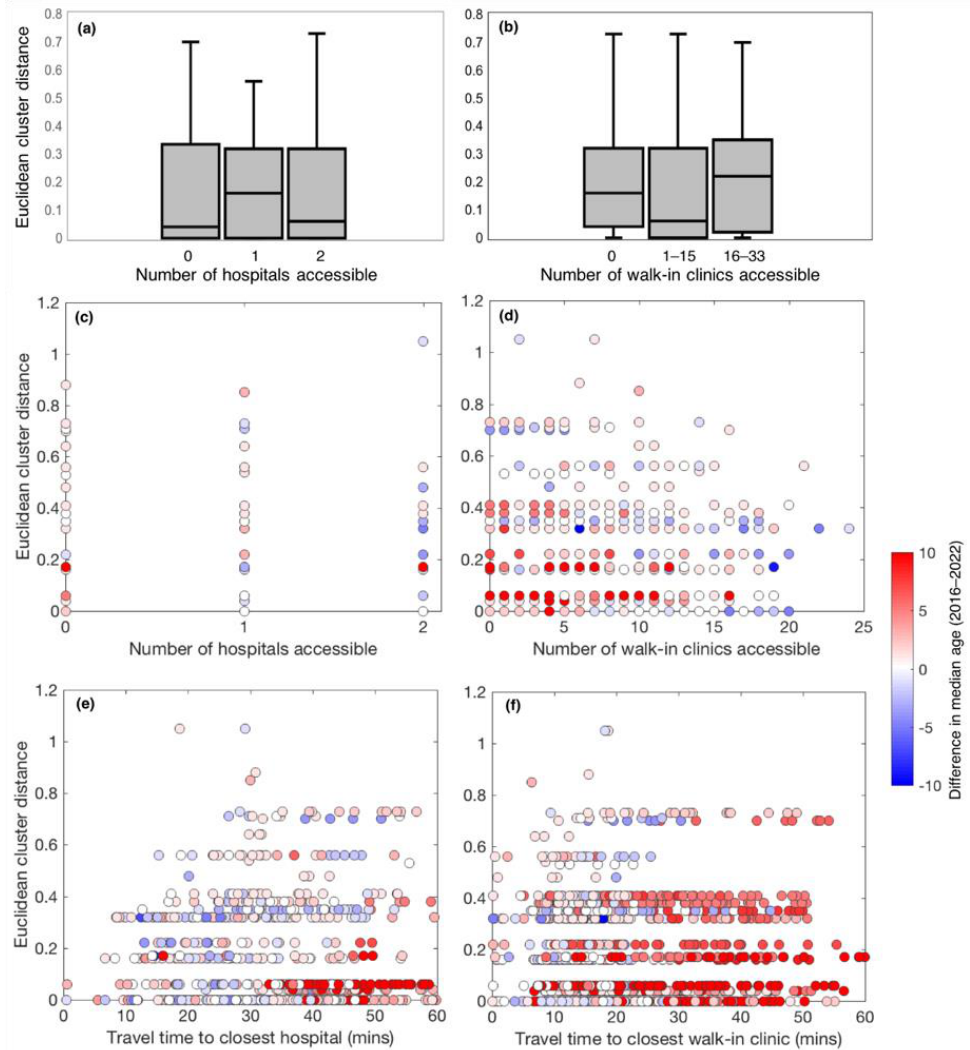
Figure 8. ( a , b ) Box-and-whisker plots of cluster distance, grouped by level of accessibility, to ( a ) hospitals and ( b ) walk-in clinics; ( c – f ) Scatterplots showing relationships between access to healthcare facilities and the Euclidean cluster distance for each cell, with a third (coloured) variable showing the difference in median age between 2016 and 2022.